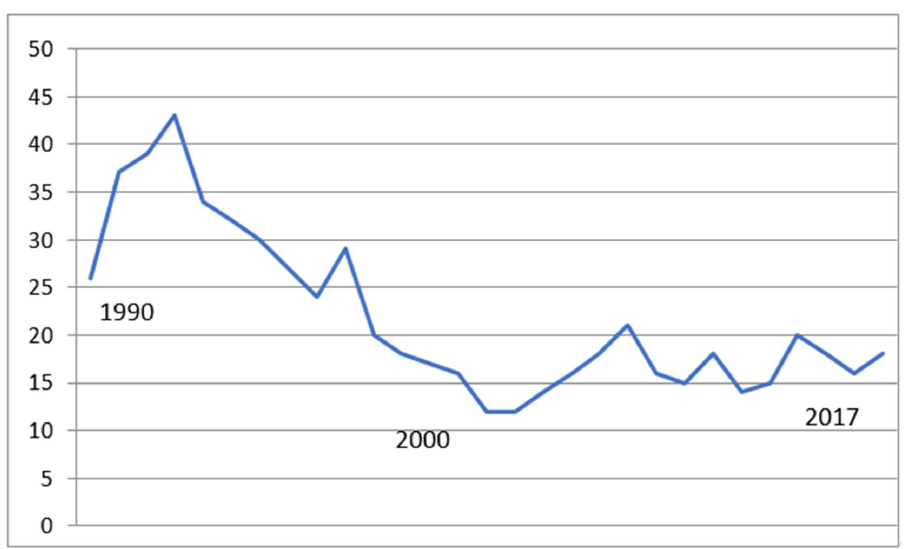
Figure 2. Post GEM transfer length of stay (LOS) (days). Mean LOS (1987–2000) 29.9 (SD 4.8) days,